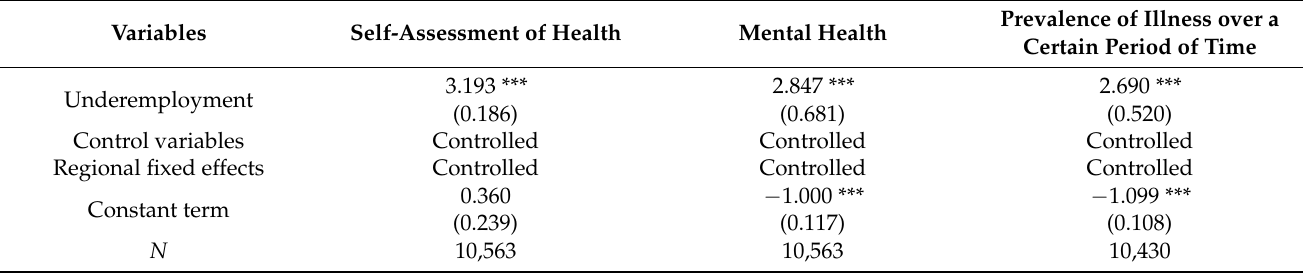
Table 5. Underemployment and the short-term health status of workers: Instrumental